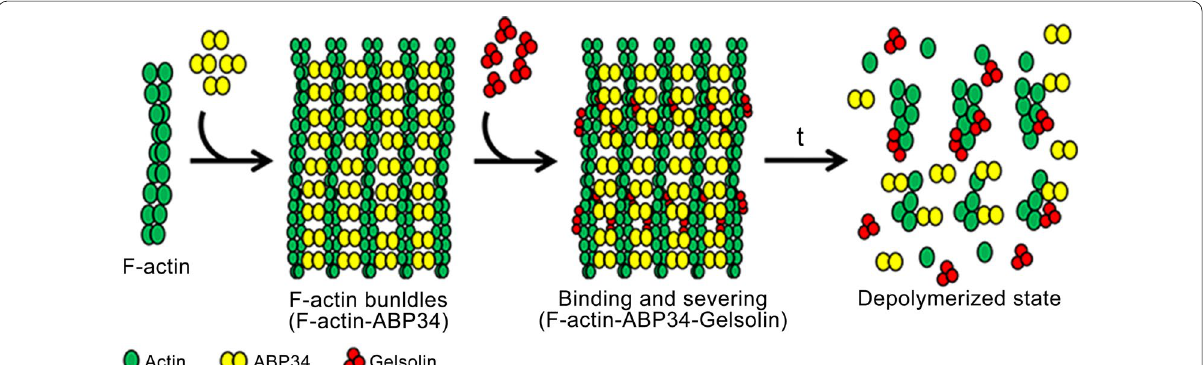
Fig. 4 A schematic outline of actin‑bundling and severing activity from this study. This schematic model elucidates a consolidated approach and correlation of the three key proteins involved in this study shown as actin‑bundling (F‑actin‑ABP34) to actin‑severing (F‑actin‑ABP34‑Gelsolin) activities. t, time; Green circle, actin; yellow circle, ABP34; red circle,